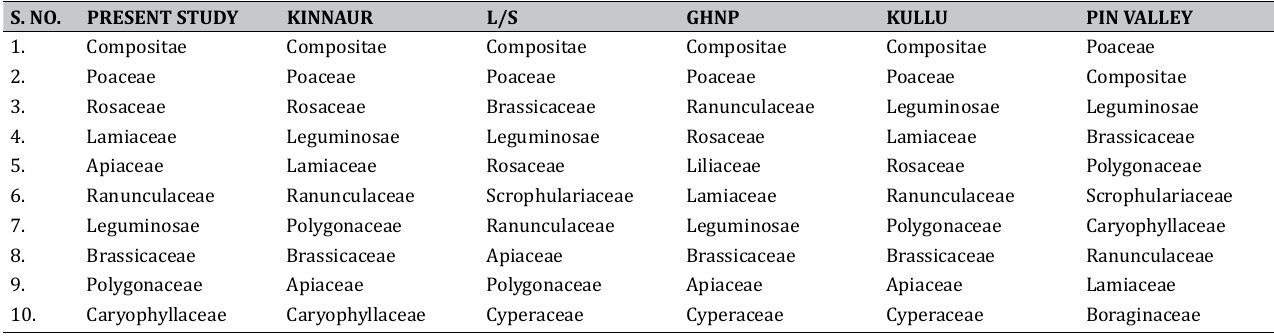
Comparative studies of dominant families in NW Himalaya. S.